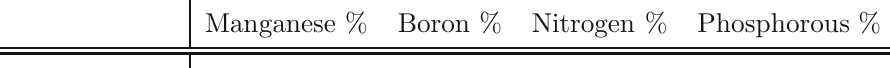
Table 1 Elemental Analysis Results of (NH 4 ) x Mn ((3 − x ) / 2) (H 2 O) 2 [BP 2 O 8 ] · (1-x)H 2 O (x = 0.5). Manganese %